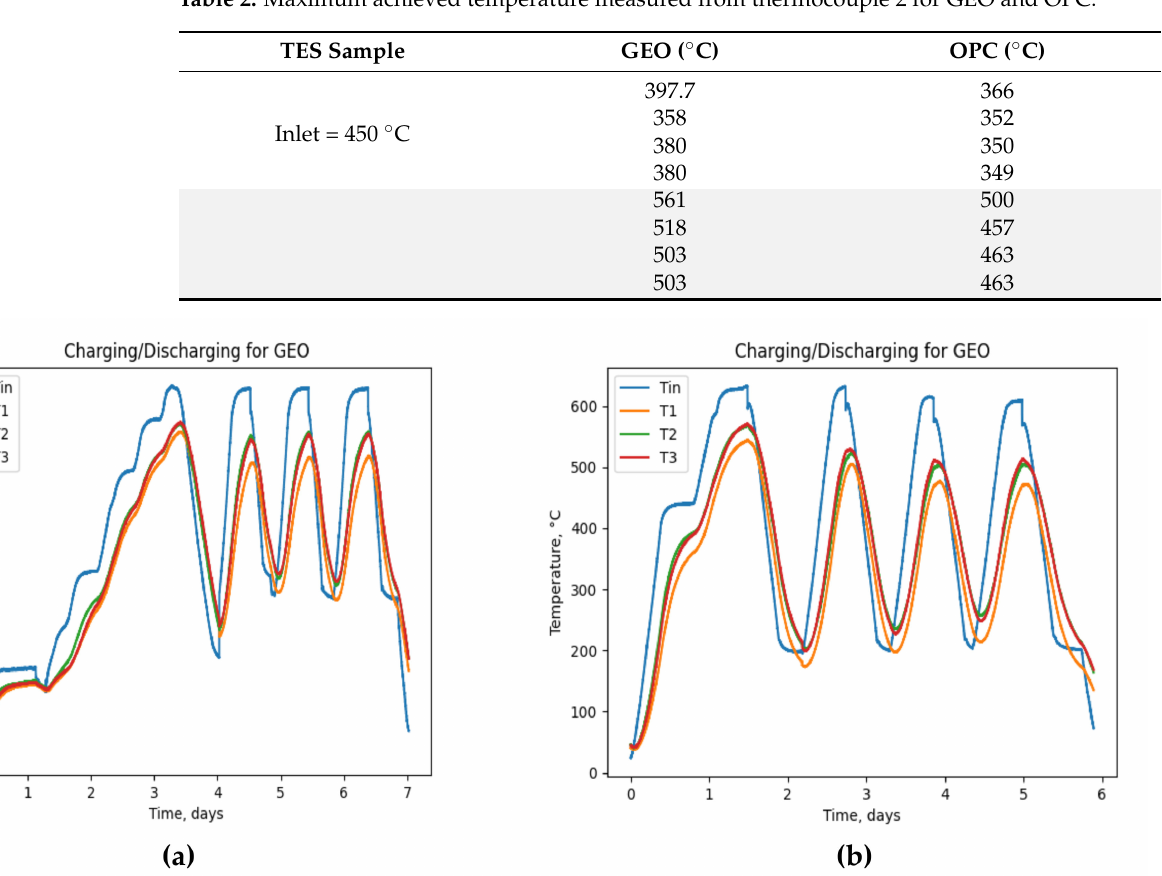
Table 2. Maximum achieved temperature measured from thermocouple 2 for GEO and OPC.